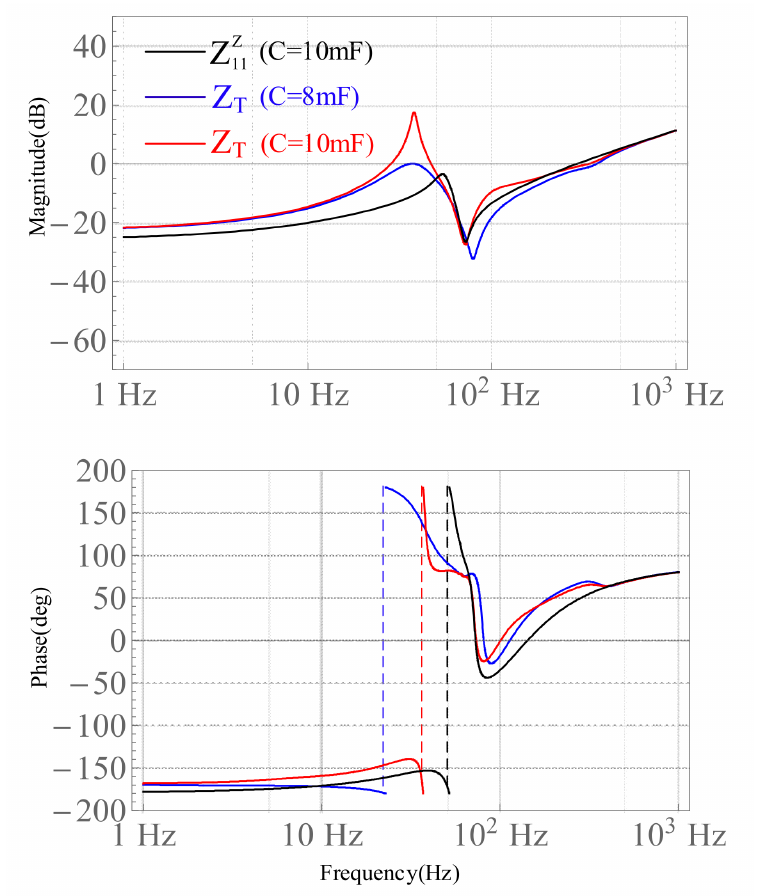
Figure 4. Impedance curves with different sizes DC capacitor ( Z Z tive sequence perturbation without frequency coupling. Z T is the entire impedance of DFIG system considering the cross-coupling